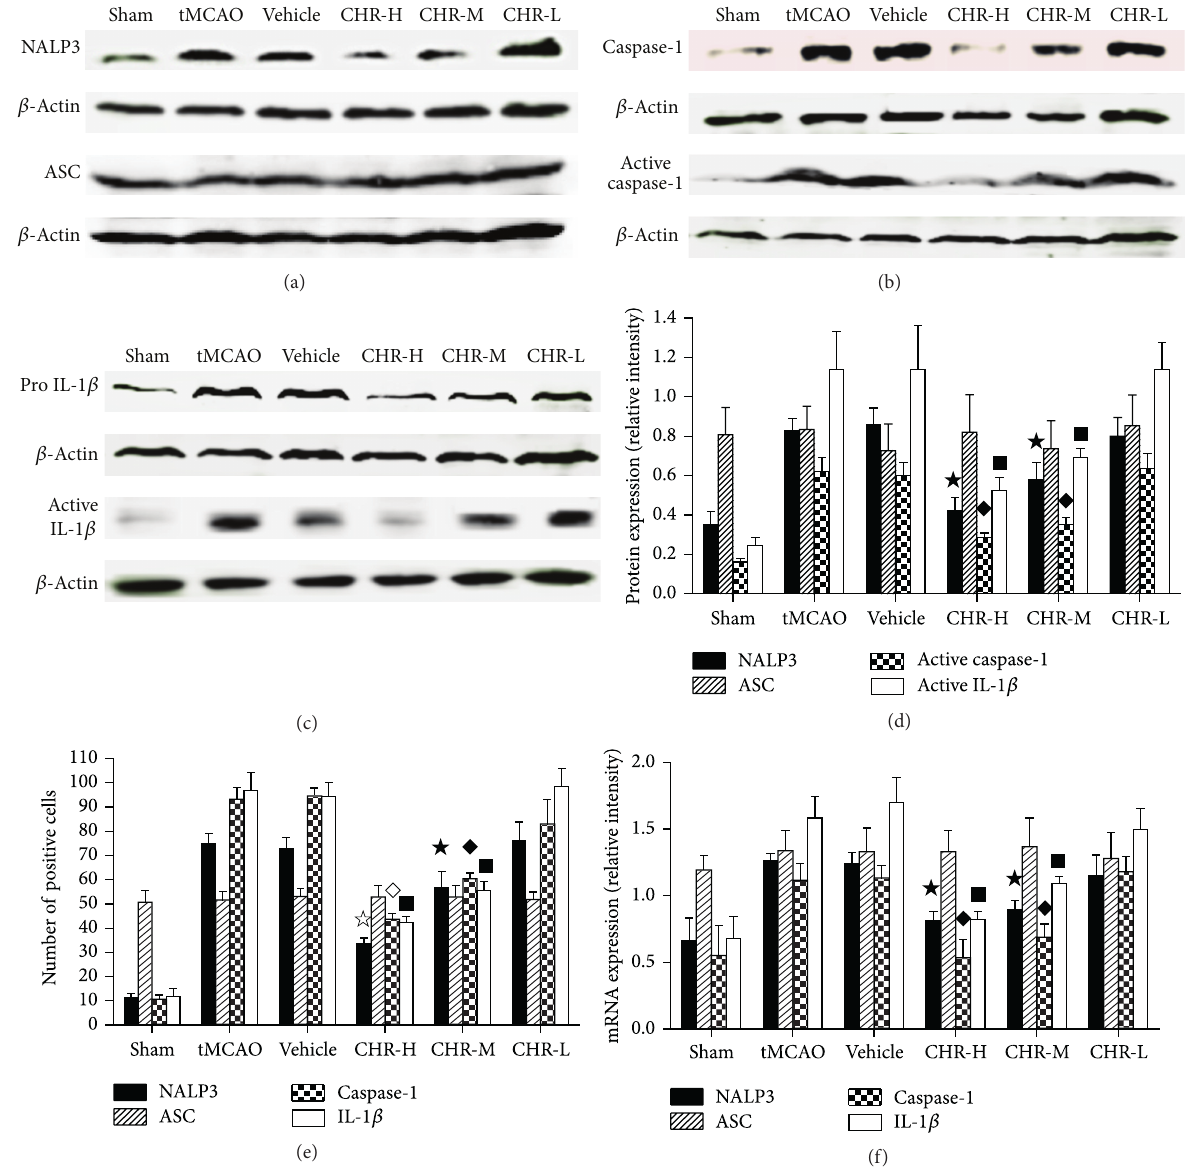
Figure 7: Effect of CHR on protein expression of NALP3, ASC (a), caspase-1, active caspase-1 (b), pro IL-1 𝛽 and active IL-1 𝛽 (c). For NALP3, active caspase-1 and active IL-1 𝛽 , 󳀅 𝑃 < 0.05 , X 𝑃 < 0.05 and ◼ 𝑃 < 0.05 versus tMCAO and Vehicle (d). Bar graph of immunohistochemistry illustrating the expression of NALP3 ( f 𝑃 < 0.05 versus tMCAO, Vehicle and CHR-M, 󳀅 𝑃 < 0.05 versus tMCAO, Vehicle), ASC, caspase-1 ( ◊ 𝑃 < 0.05 versus tMCAO, Vehicle and CHR-M, X 𝑃 < 0.05 versus tMCAO, Vehicle) and IL-1 𝛽 ( ◼ 𝑃 < 0.05 versus tMCAO and Vehicle) (e). Bar graph illustrating CHR reduced to mRNA of NALP3, caspase-1 and IL-1 𝛽 ( 󳀅 𝑃 < 0.05 , X 𝑃 < 0.05 and ◼ 𝑃 < 0.05 versus tMCAO and Vehicle)